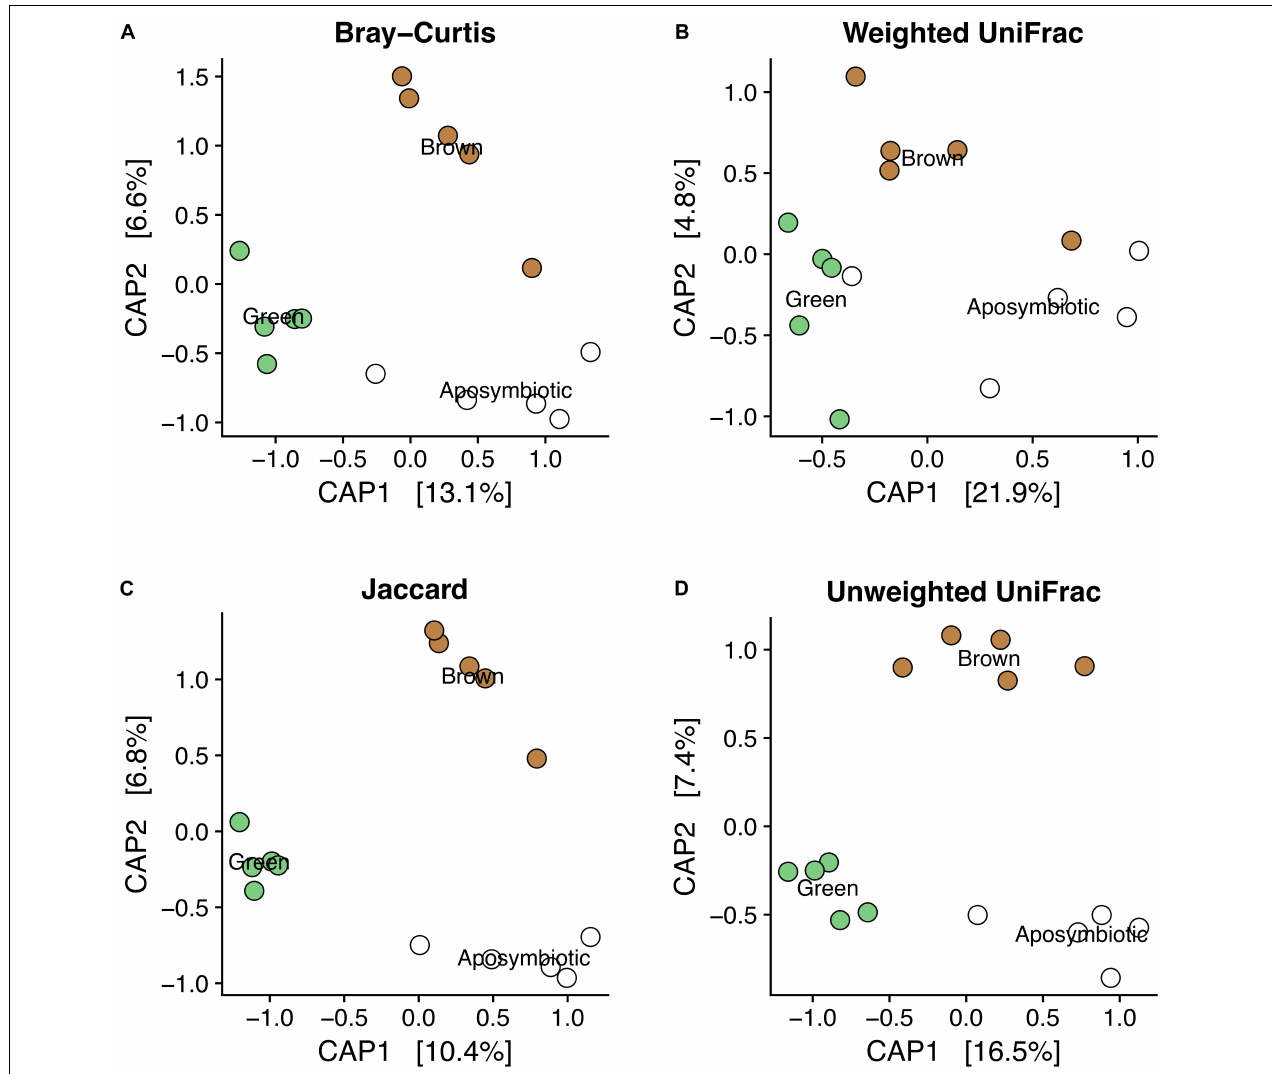
FIGURE 3 | CAP ordination plots of (A) Bray-Curtis, (B) Weighted UniFrac, (C) Jaccard, and (D) Unweighted UniFrac beta diversity metrics reveal structure in microbial communities associated with A. elegantissima in different symbiotic states. Clustering by symbiotic state was robust to the metric